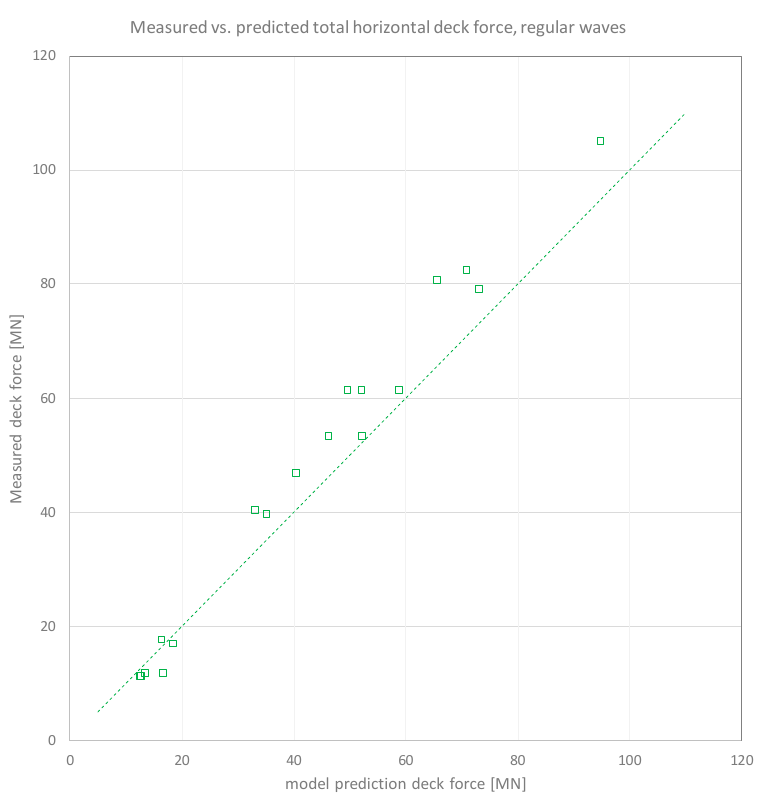
Figure 13. Correlation between measured deck impact load peaks and model predictions, regular waves: ( top ) local horizontal slamming pressure; and ( bottom ) global horizontal force.